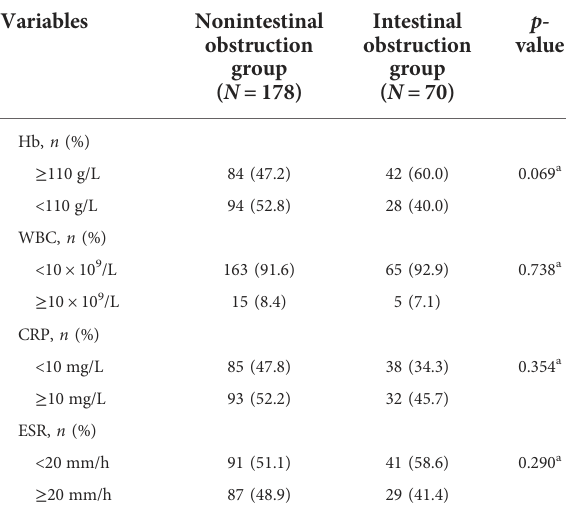
TABLE 4 Univariate analysis of risk factors for intestinal obstruction in CD